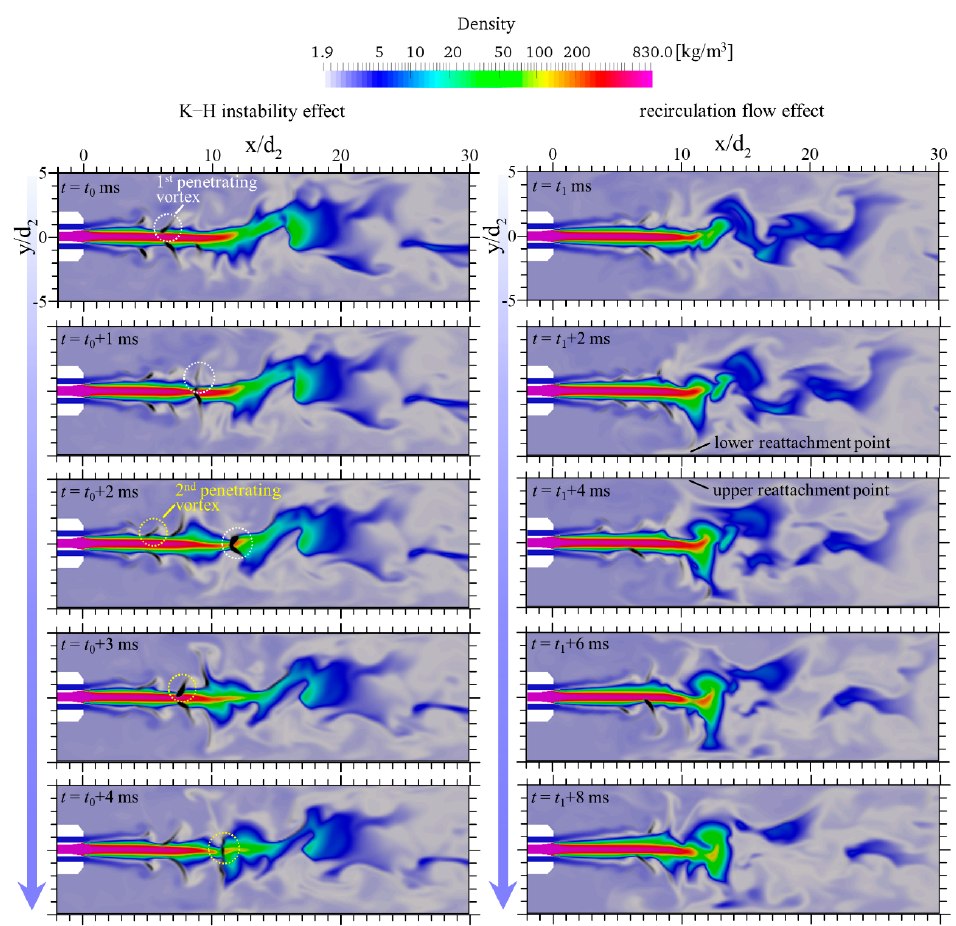
Figure 9. Enhancement of propellant mixing by K–H instability effect and recirculation flow effect with contour of density and heat release rate (white: 0 W/m 3 , black: 2 × 10 14 W/m 3 ). Legend of density is expressed in log scale.